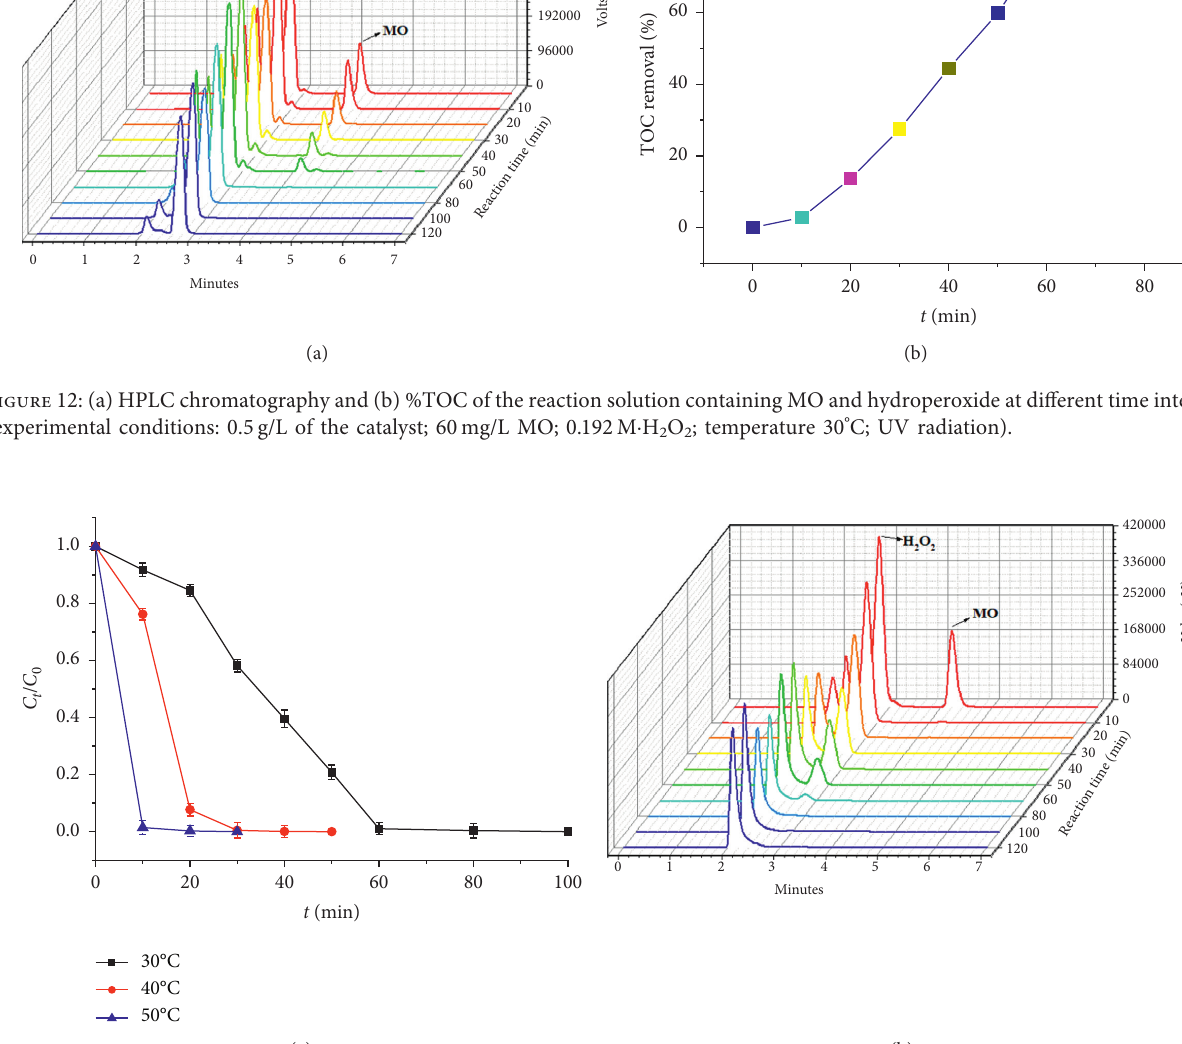
Figure 13: (a) MO decomposition profile using the heterogeneous UV/Fenton-like MIL-53 catalyst at different reaction temperatures; (b) HPLC chromatograms of the reaction solution containing MO and hydroperoxide at 50 ° C at different reaction times (experimental conditions: 0.5/L g of the catalyst; 120mg/L MO; 0.192M H 2 O 2 ; UV